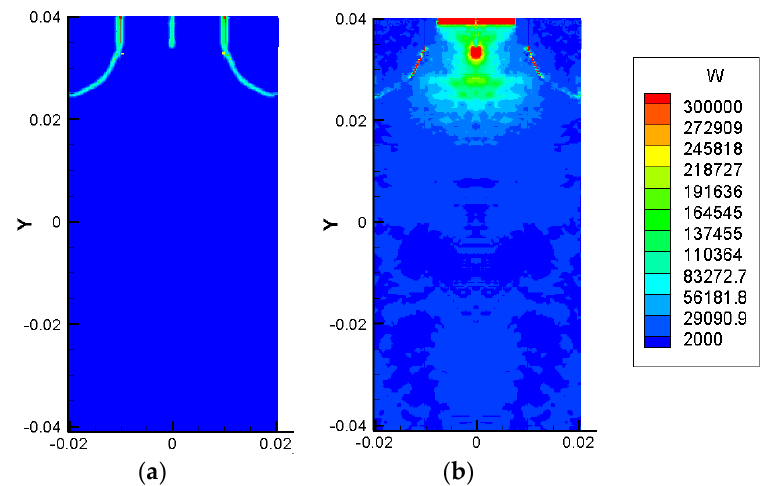
Figure 14. The surface crack growth of the homogeneous coating substrate sample at t = 100 µs under impact load: ( a ) crack map; ( b ) elastic energy density.